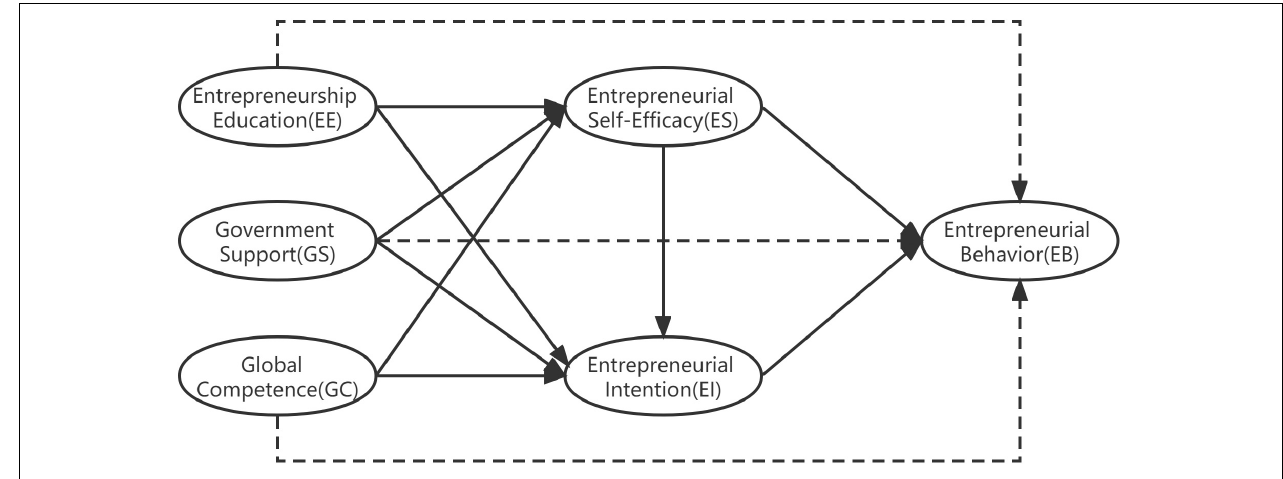
FIGURE 1 | Hypothesized model. Arrows represent hypothesized